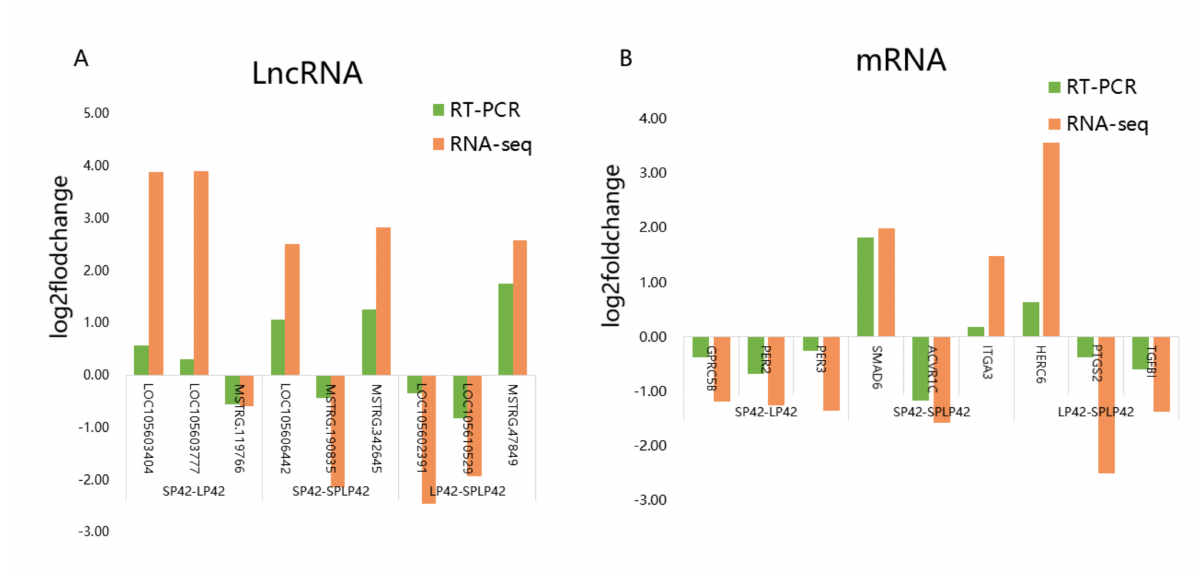
Figure 7. Validation of RNA sequencing (RNA-seq) data using RT-qPCR. ( A ) RNA-Seq and RT-qPCR results of three selected differentially expressed lncRNAs in the thyroid gland of Sunite sheep at different photoperiods. ( B ) RNA-Seq and RT-qPCR results of three selected differentially expressed mRNAs in the thyroid gland of Sunite sheep at different